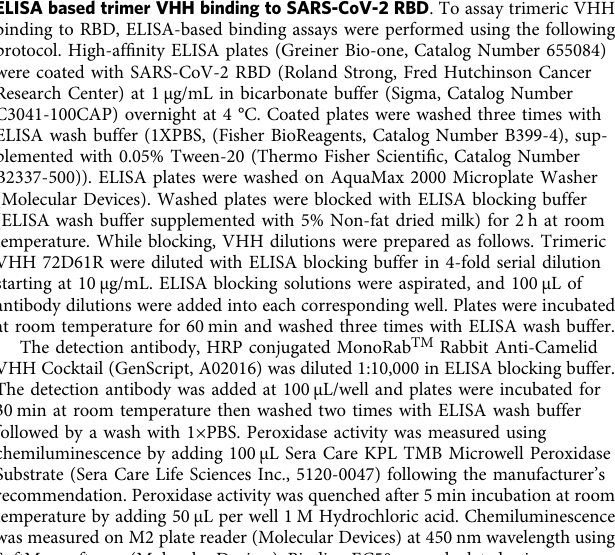
Fig. 7; BLI and ELISA assays for VHH-tcTRP constructs in Fig. 8 and viral pseudoneutralization assays in Fig. 8) were conducted in triplicate using inde- pendent aliquots of each protein. Data are shown as mean and standard for n = 3